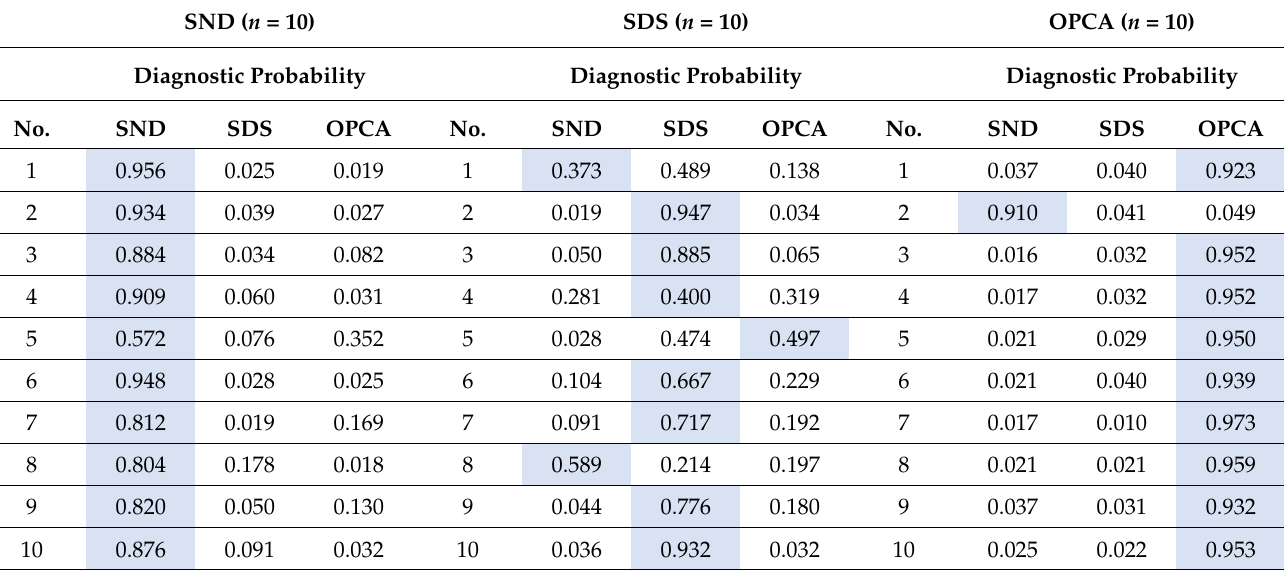
Table 5. Diagnostic probability estimated using the point-wise linear